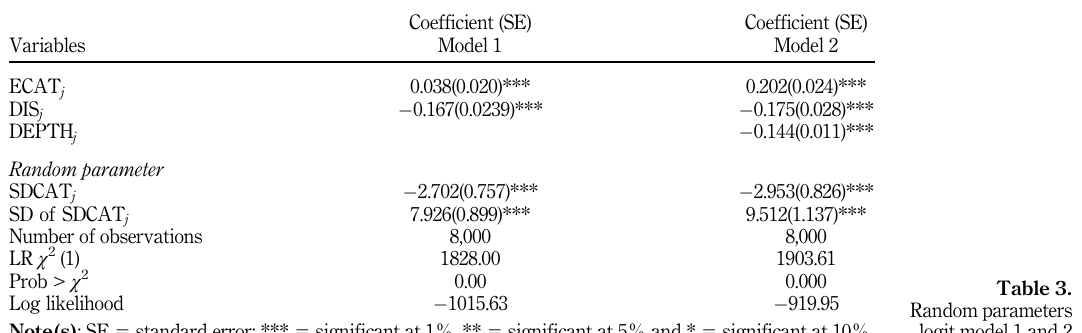
Table 3. Random parameters